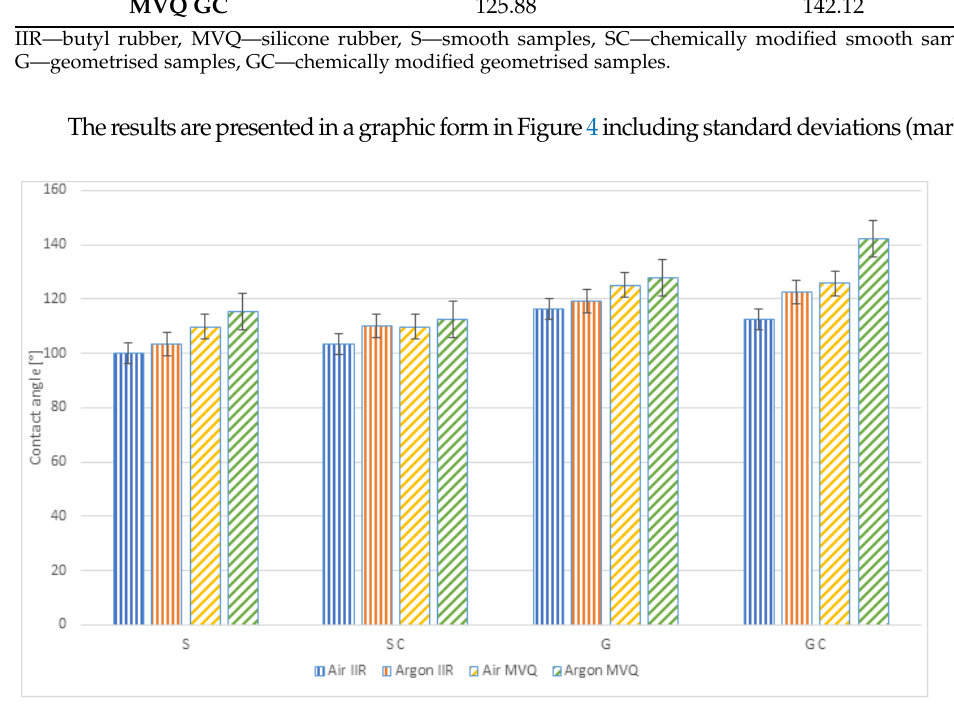
Figure 5. IR spectra of polymer materials made of silicone rubber (SC — chemically modified smooth samples, GC — chemically modified geometrised samples subjected to plasma modification in the air (PP) or argon (PA), and for non-modified polymer material made of silicone rubber).